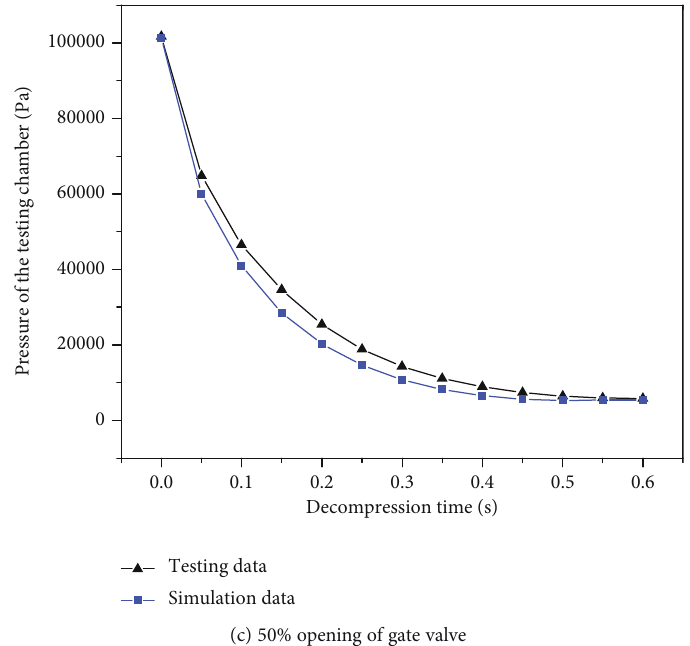
Figure 9: Comparison and veri fi cation between testing and simulation data of the testing